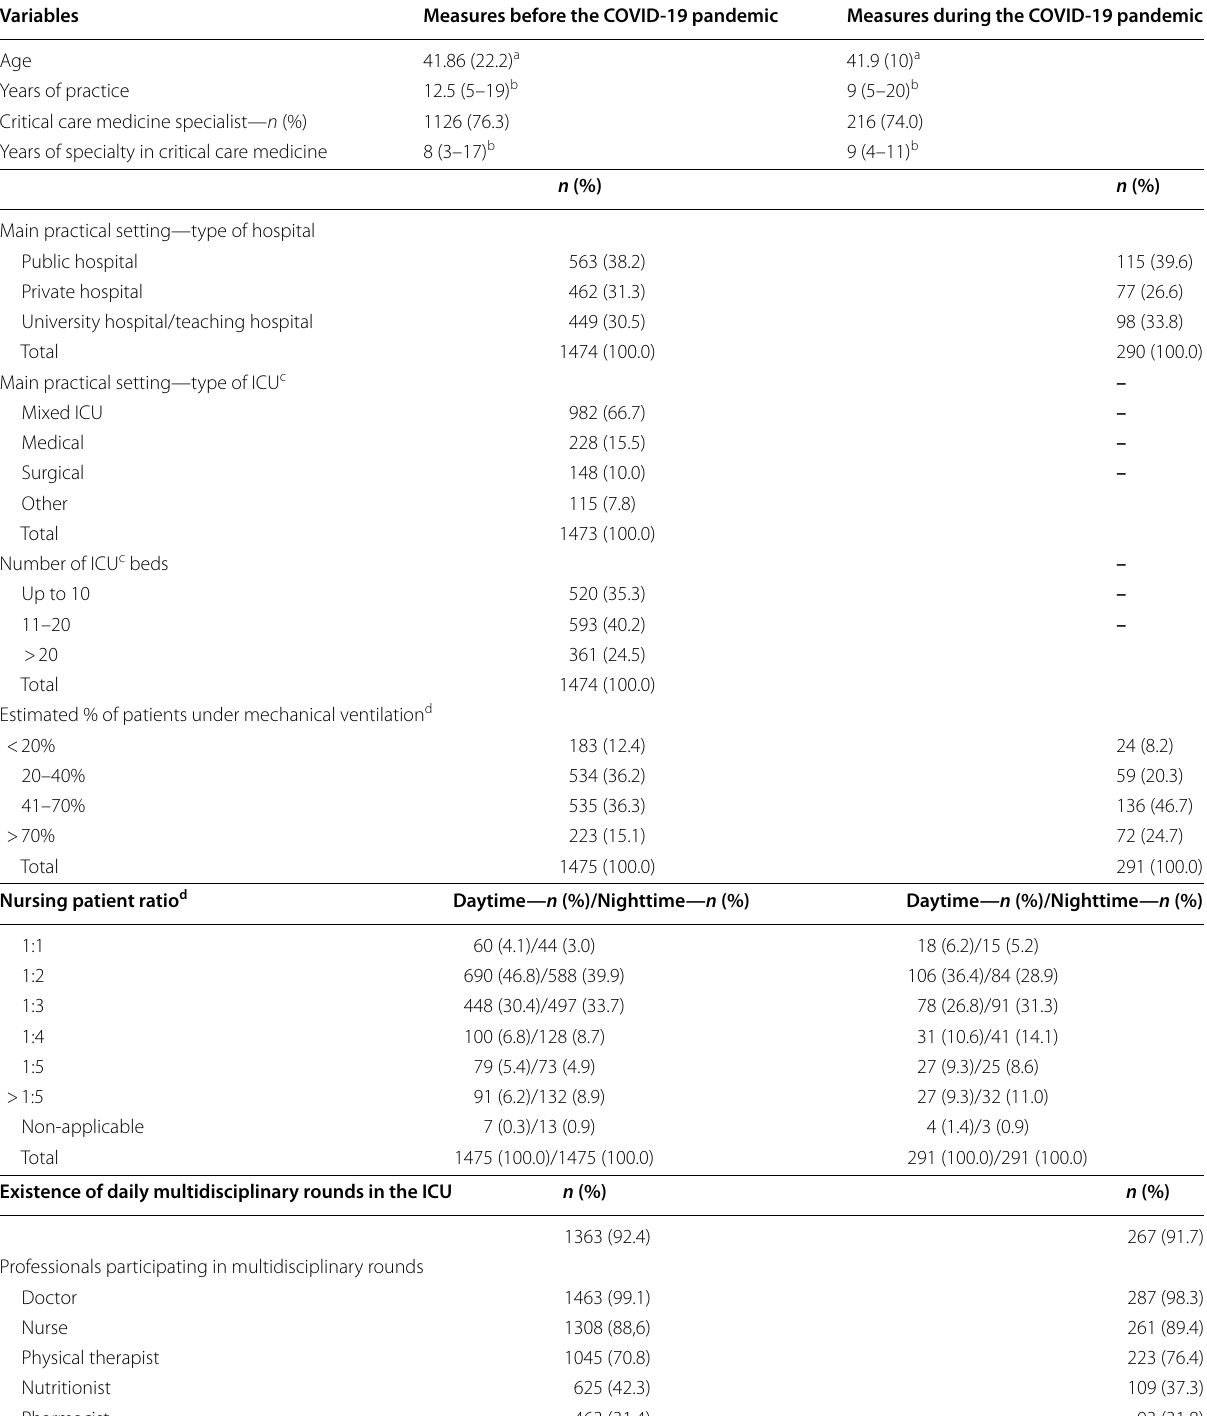
Table 1 Survey respondent demographics and their main practical setting